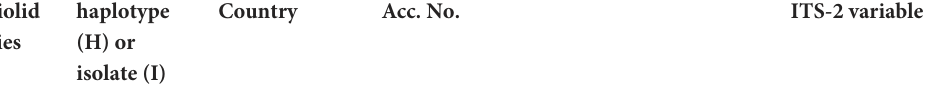
TABLE 4 Polymorphic sites in the sequence comparison of the nuclear rDNA ITS-2 between haplotypes of “genetically pure” Fasciola hepatica from livestock in Europe and the Americas, “genetically pure” F. gigantica from livestock in African countries, F. nyanzae from hippopotamuses in the nature reserves in South Africa, and from snails and one hippopotamus in Zimbabwe, Fascioloides jacksoni from elephants in Sri Lanka, and Fs. magna from cervids in